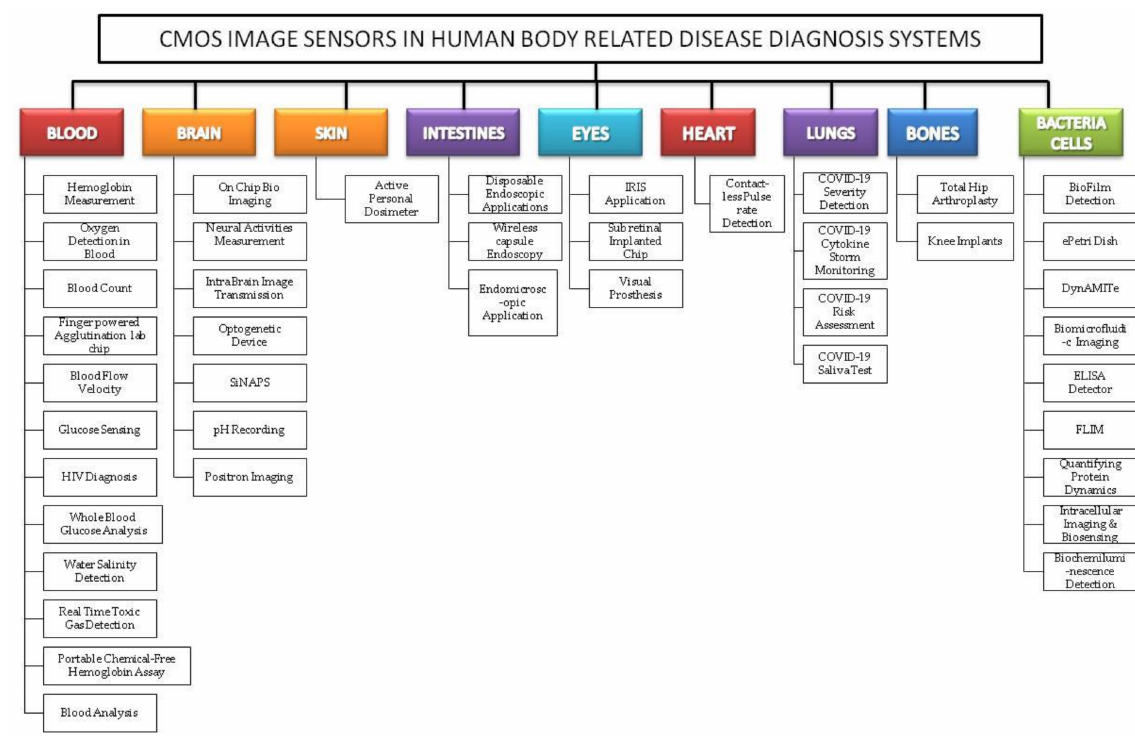
Figure 3. Classification of complementary metal-oxide semiconductor image sensor (CIS) embedded disease diagnosis systems relating to vital signs and organs of the human